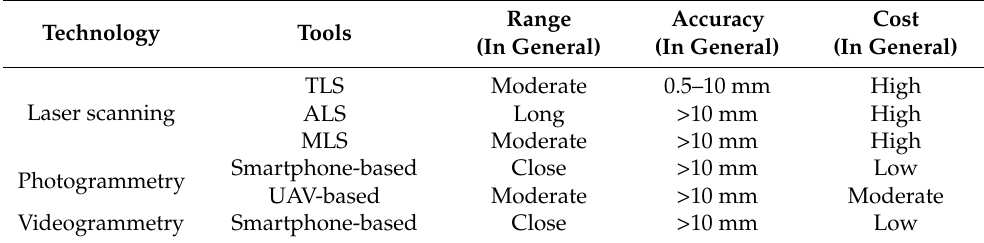
Table 6. Comparison of different point clouds acquisition